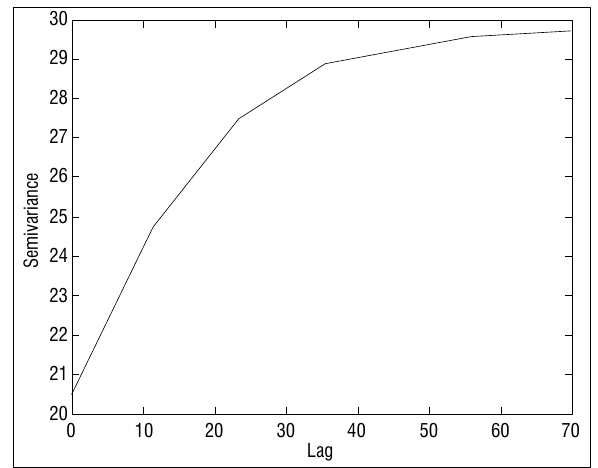
Figure 3: Semivariogram of the observed data. The 200 points selected for training and testing were split into classes of 10 (Figure 4). The box plot in Figure 4 shows the statistical distribution of the data. The inner line of the box indicates the median of the data. The top of the upper tail indicates the highest value of the data, while the bottom of the lower tail indicates the lowest value of the data. The experiment was implemented with an optimal  -sensitive function value  =0.1. The polynomial, radial basis function and the linear kernels were investigated to select the best kernel function for the experiment, through the method of cross-validation.